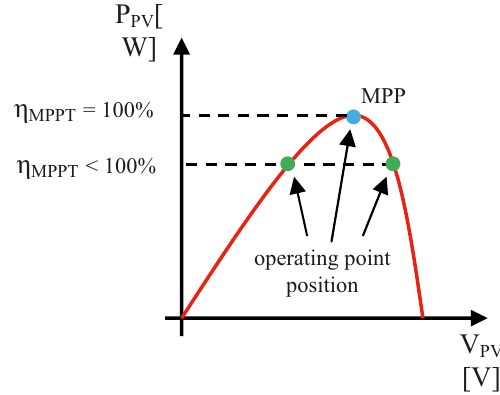
Fig. 2. Evaluation of the MPPT